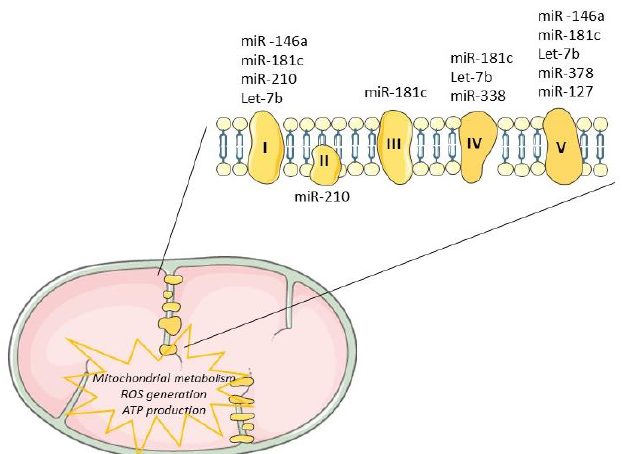
Figure 4. Mitochondrial miRNAs modulate metabolic processes. Mitochondrial miRNAs have been shown to regulate the mitochondrial electron transport chain by targeting multiple proteins. By impacting mitochondrial metabolism, ROS generation and ATP production, mitomiRs are important contributors for tissue regeneration.